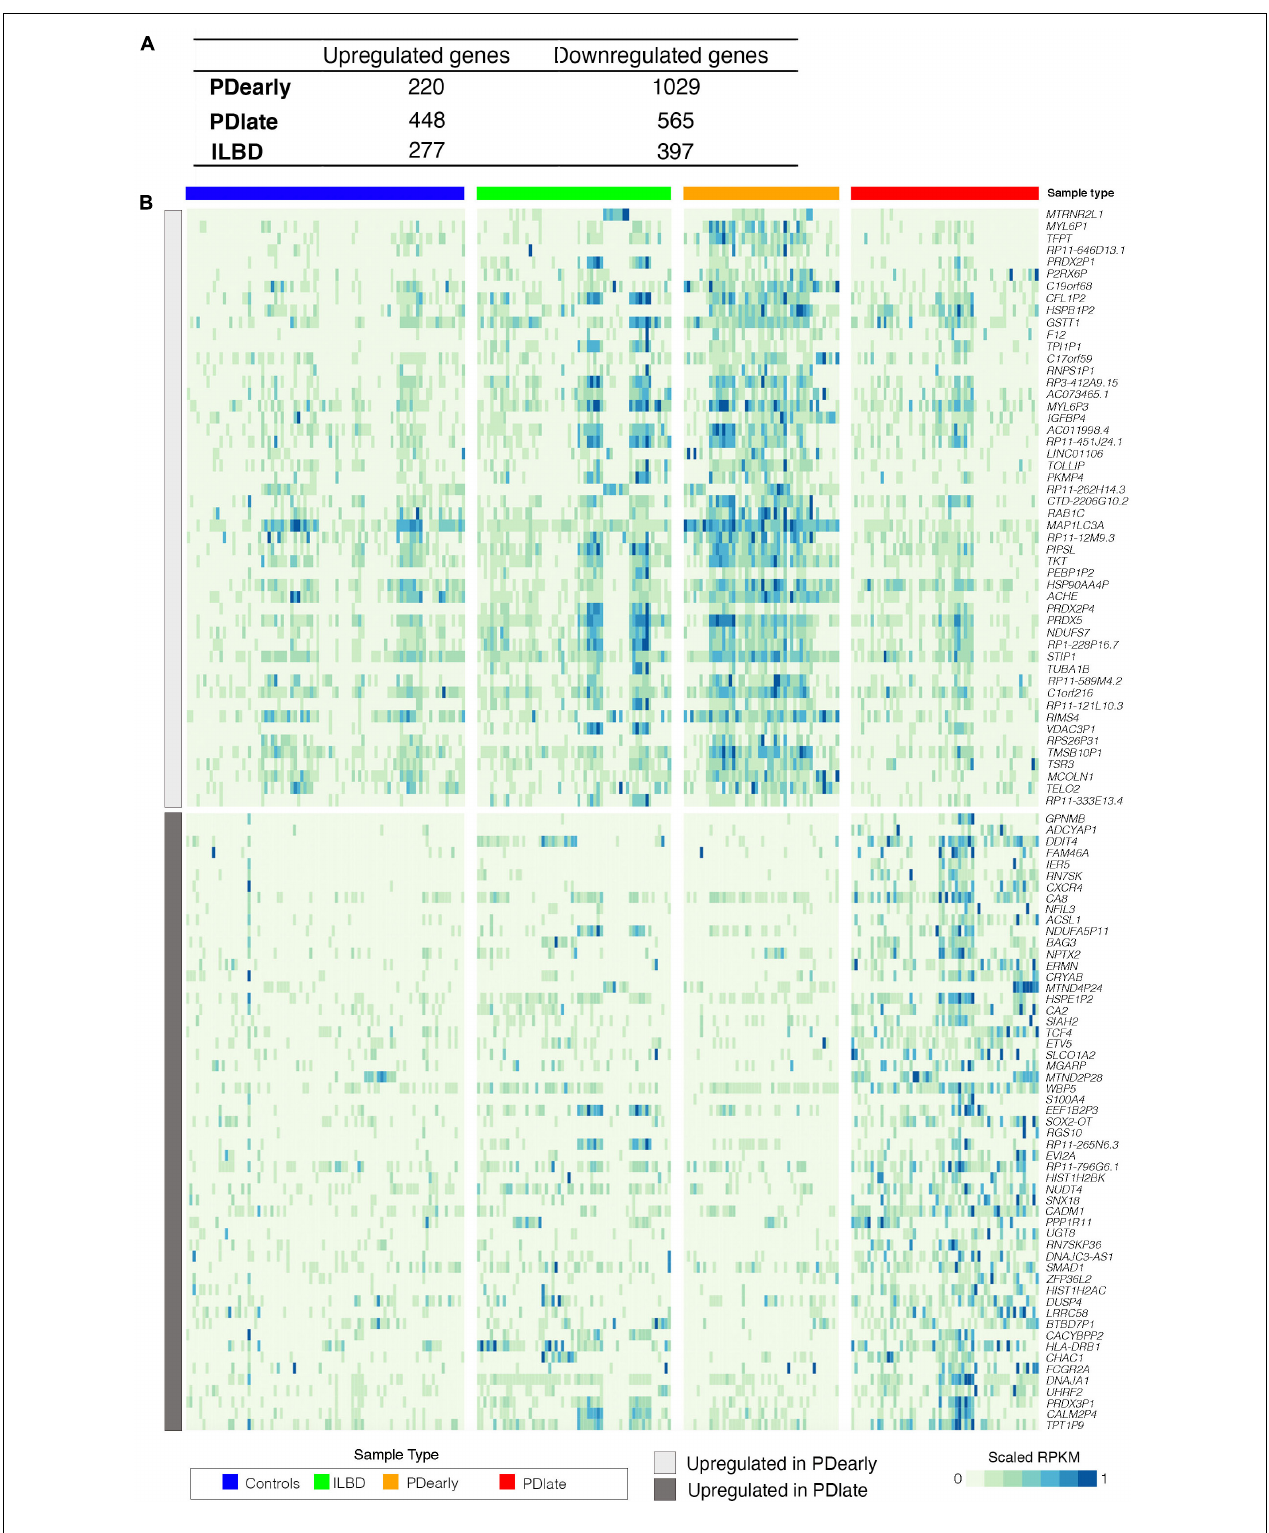
FIGURE 4 | Gene expression changes in PDearly, PDlate and incidental Lewy body disease. (A) Number of up- and down-regulated genes in PDearly, PDlate and incidental Lewy body disease (padj < 0.05, RPKM > 1, fold change > 1.5). (B) Heatmap visualizing expression of top-upregulated genes in PDearly and PDlate. Sample types are indicated by color coding. Genes upregulated early are in the top part of the heatmap (light gray) while genes upregulated late are in the bottom part (dark gray).